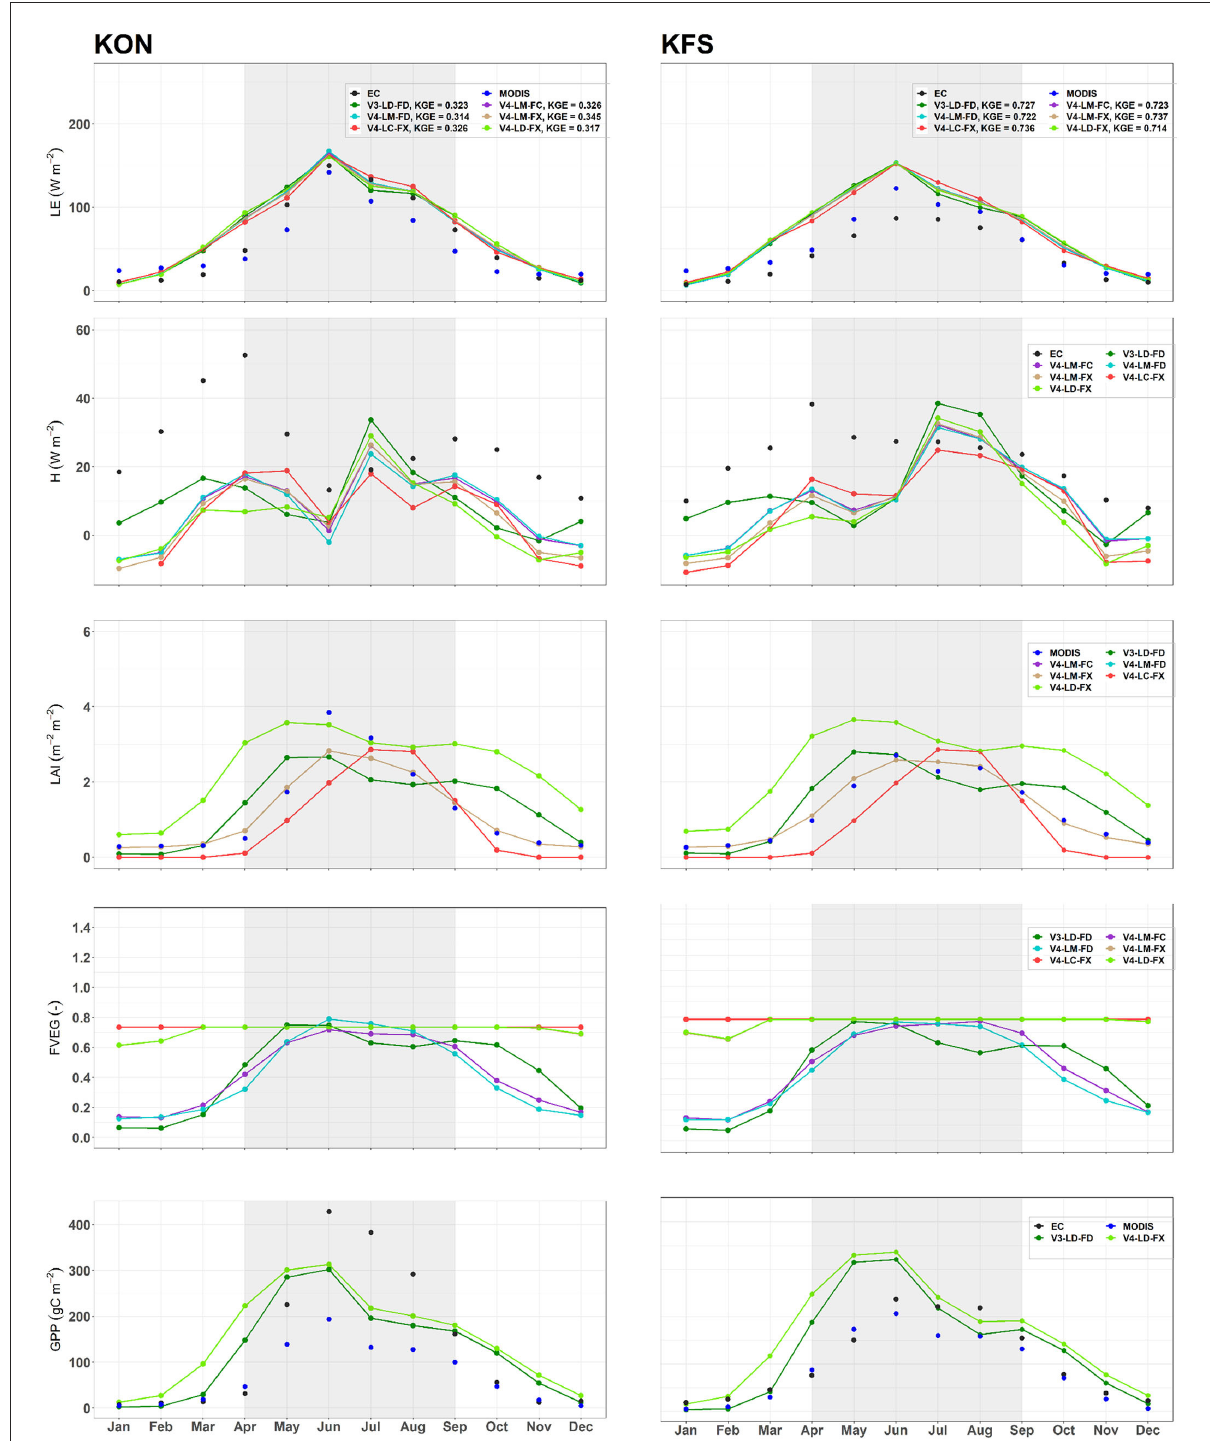
FIGURE3 Seasonal climatology of simulated LE, leaf area index (LAI), fractional vegetated area (FVEG), and GPP from different Noah-MP configurations vs. MODIS and EC measurements during the 11-year study period for KON and KFS sites. Gray-shaded areas denote the growing